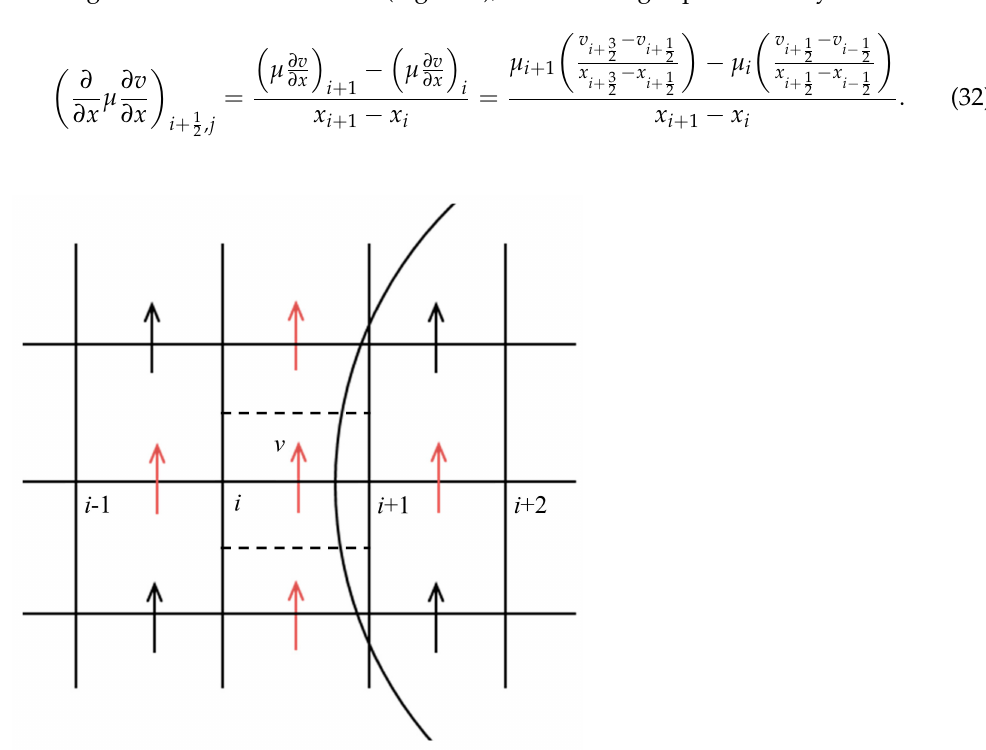
Figure 7. Evaluation of the second order derivative closer to the